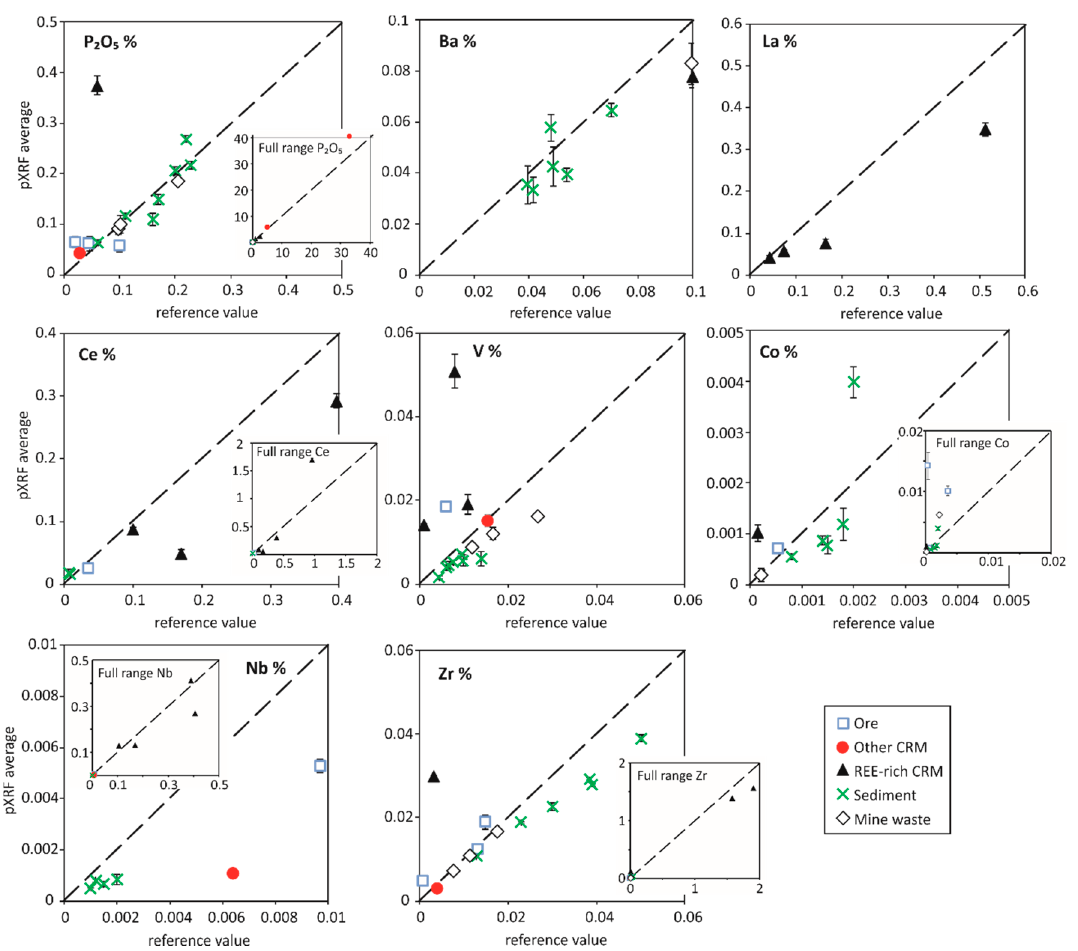
Figure 2. Comparison of pXRF averages and reference values of 21 certified reference materials (CRMs). Not all of the critical element values are certified, some are provisional or informational only. The stippled 1:1 line indicates how well the pXRF averages agree with the reference value.